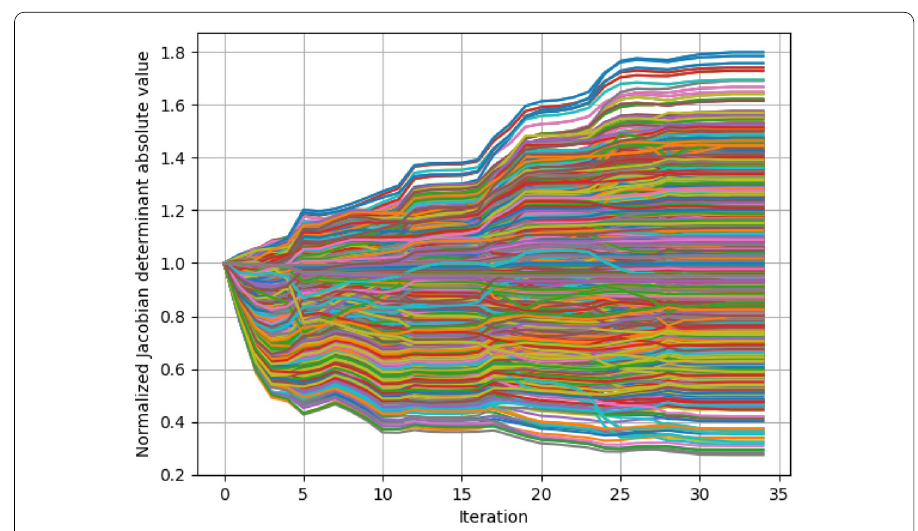
Fig. 16 Example of the orthotropic plate with two holes: evolution of the transformation Jacobian of each Gauss point as a function of the iteration number for the second optimization run ( (cid:5) Jac = 0 . 1)